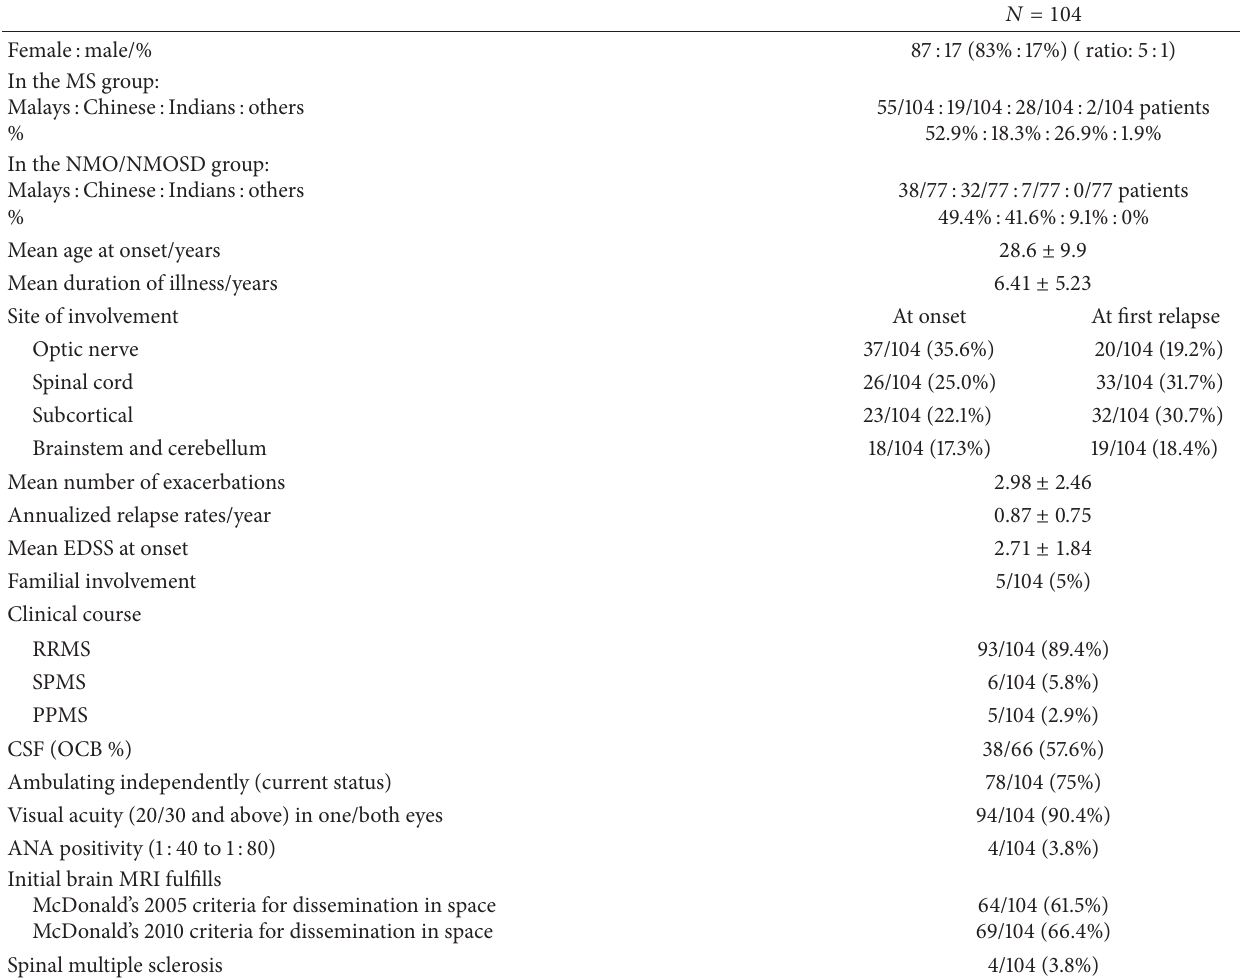
Table 2: Showing the clinical features of multiple sclerosis patients in Malaysia. (A subgroup analysis of demographics in NMO/NMOSD patients was also